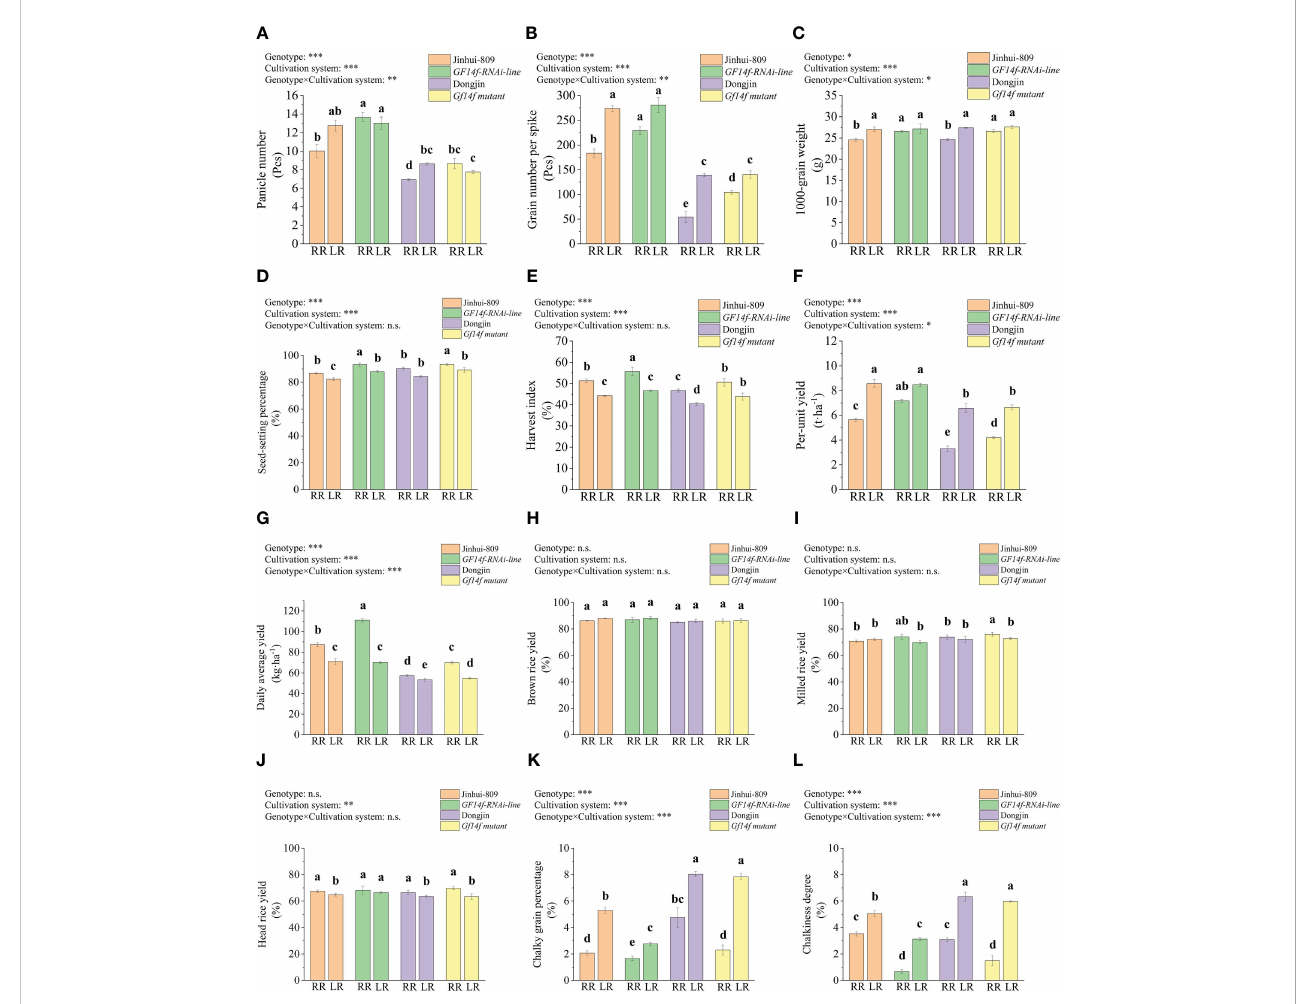
FIGURE 1 Comparisons in grain quality and yield performance between GF14f-RNAi line , GF14f mutant and their WT. (A) : Panicle number; (B) : Grain number per spike: (C) : 1000-grain weight; (D) : Seed-setting percentage: (E) : Harvest index; (F) : Per-unit yield; (G) : Daily average yield; (H) : Brown rice yield: (I) : Milled rice yield: (J) : Head rice yield: (K) : Chalky grain percentage: (L) : Chalkiness degree. Note: MR. RR and LR represent early-season rice, ratoon rice and late-season rice, respectively. Superscript letters indicate statistical groups that are signi fi cantly different ( P < 0.05 , ANOVA). Asterisks indicate factors contributing to the differences between samples (n.s., not signi fi cant; * P < 0.05 ; ** P < 0.01 ; *** P < 0.001